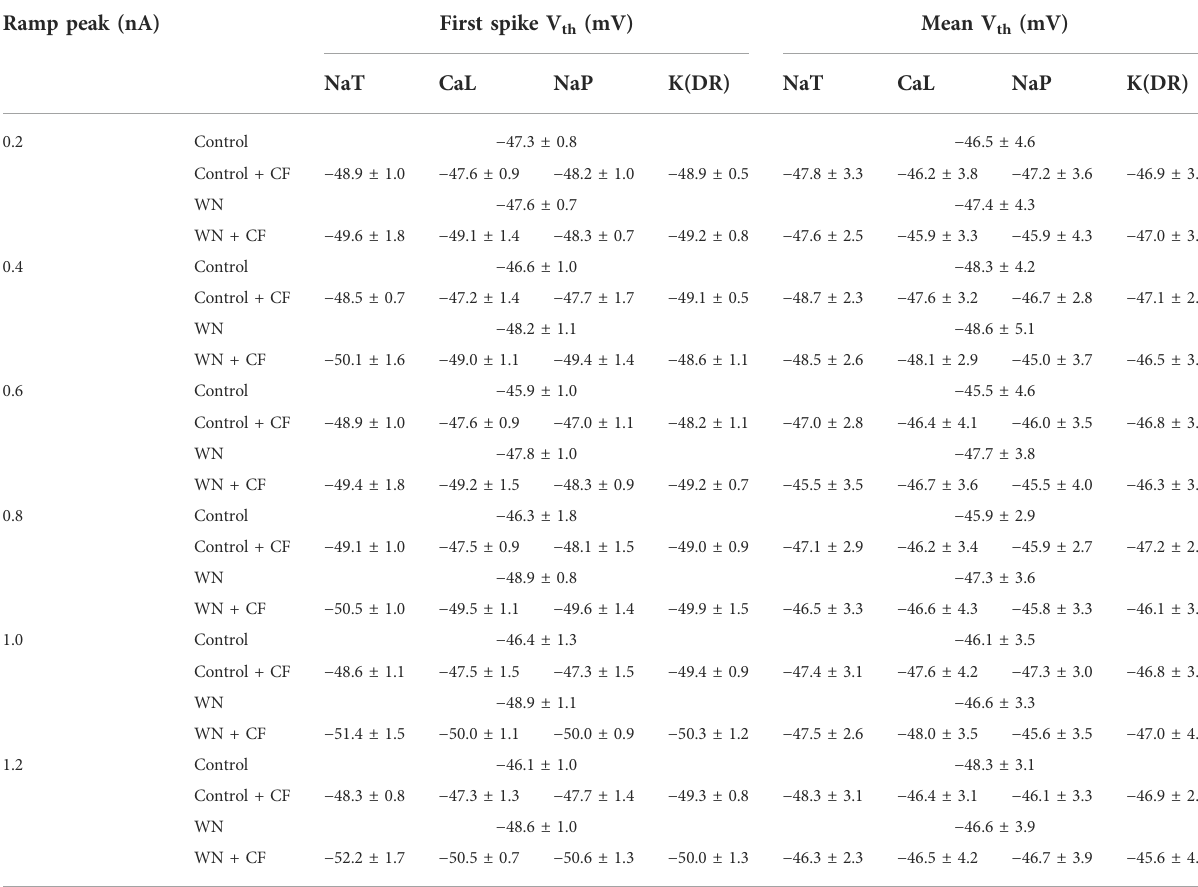
TABLE 4 Effect of channel fl icker on voltage